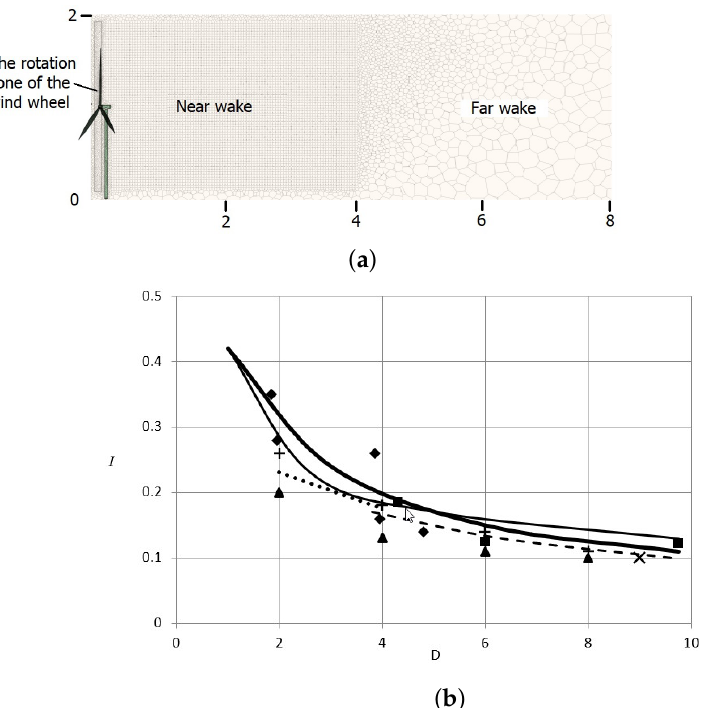
Figure 5. ( a ) Mesh scene area diagram; ( b ) Comparison of the turbulence intensity in the wake at the hub height, measured in four different clusters of wind turbines, is done with the model used, as well as the Quarton model and the Crespo and Hernandez model, 9 m/s < U < 11 m/s: solid line— Frandsen and Thogersen [5]; solid thin line—Qarton [5]; dotted line—Crespo and Hernandez [5]; (cid:4) —Alsvik [5]; × —Vindeby [5]; • —Taff Ely [5]; (cid:7) —Andros [5]; (cid:78) —turbulence intensity without a dedicated near wake in the calculated area, + —turbulence intensity with a dedicated near wake in the calculated area.